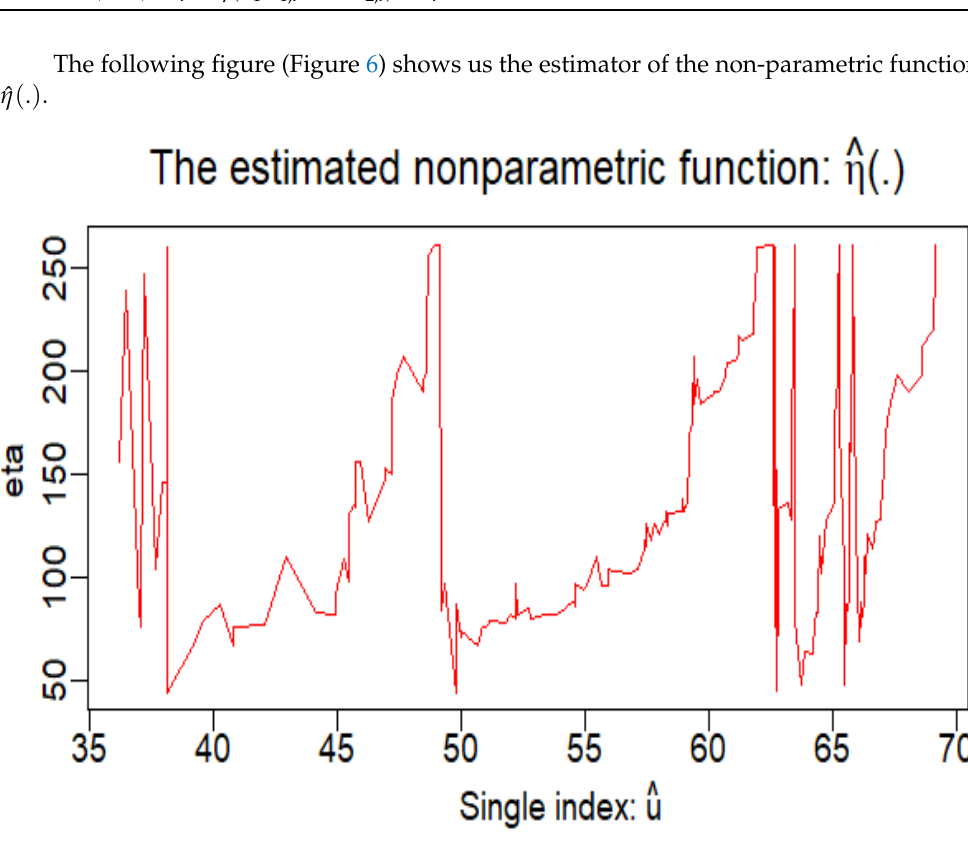
Figure 6. Estimated nonparametric function ˆ η ( . )